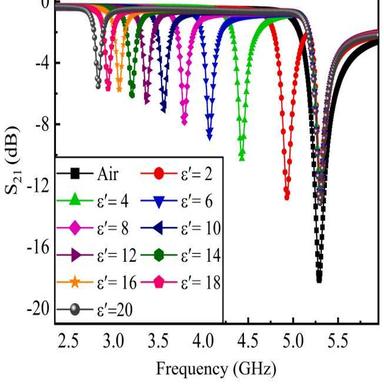
Simulation results of the sensor for the arbitrary samples.